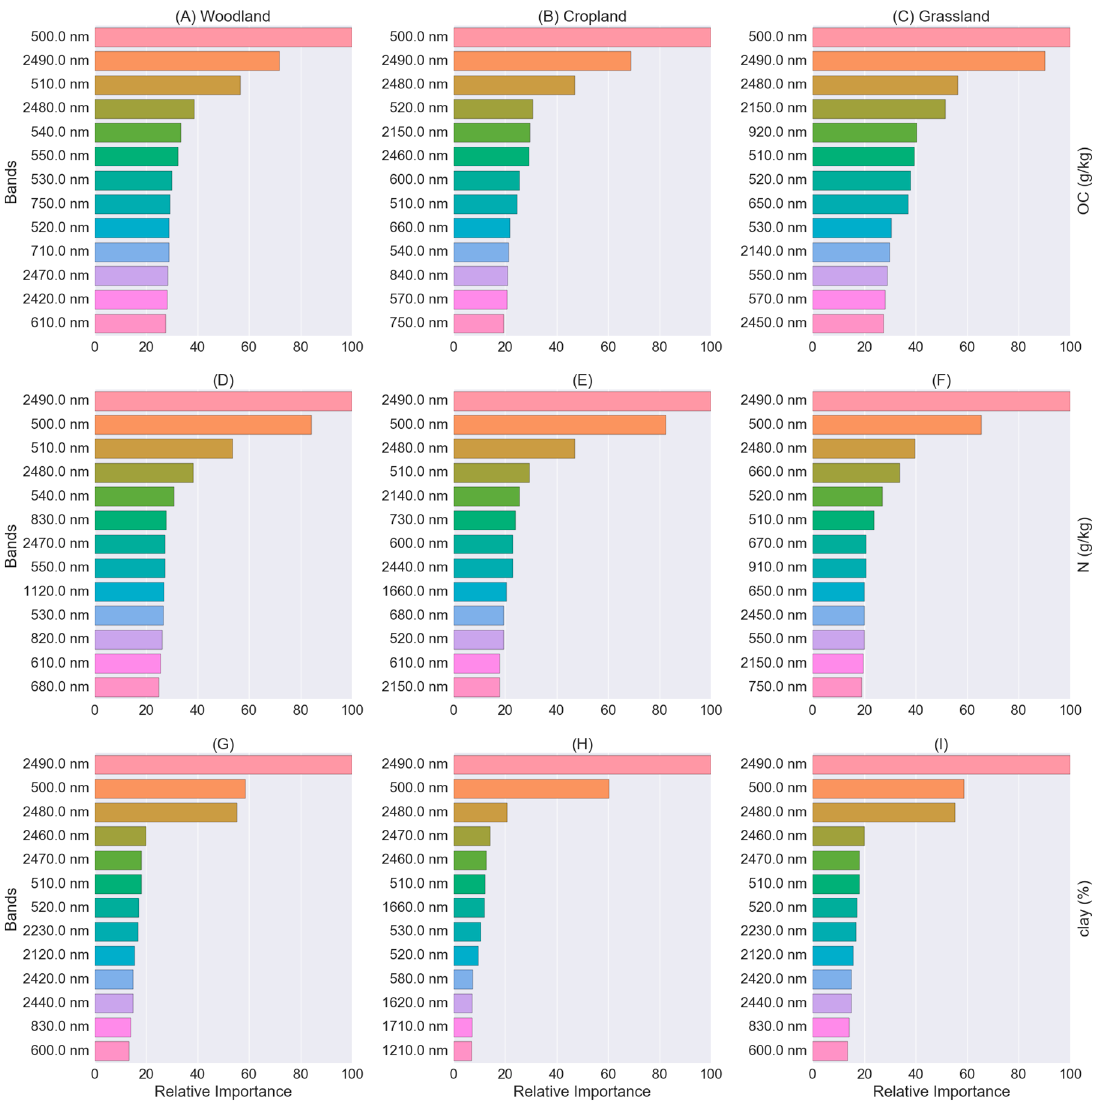
Figure 9. The top 13 relative important variables derived from GBDT models. ( A – C ) are relative important variables derived from OC models for woodland, cropland, and grassland soils, and ( D – F ) are relative important variables derived from N models, and ( G – I ) are relative important variables derived from clay models.